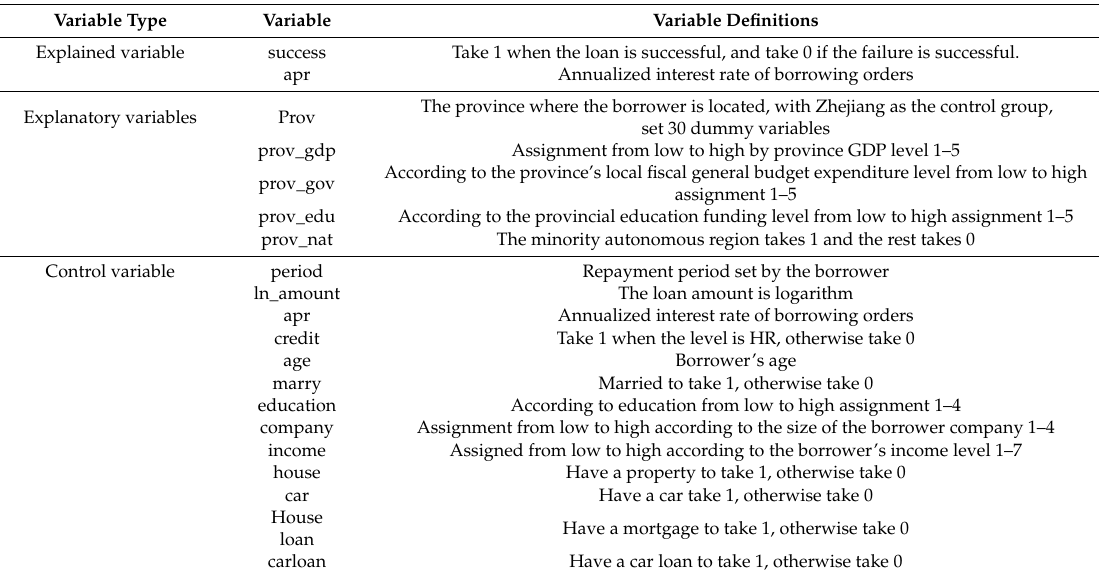
Table 2 summarizes the variables: Table 2. Variable definition and